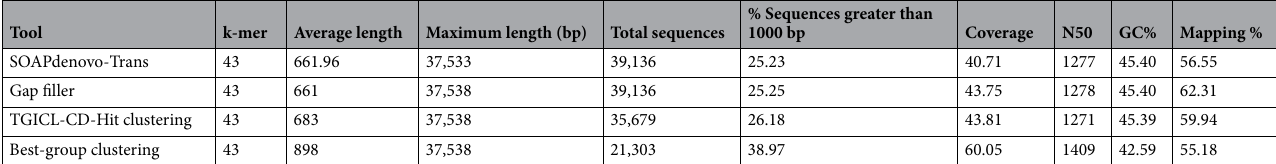
(Fig. 2). In terms of biological processes, dominance of “metabolic process” and “cellular process” was identified. Among the molecular function category, “binding”, “catalytic”, and “transporter” activity were identified as the most significant group. In terms of cellular components, “cell”, “cell part”, and “organelle” were the most domi- nant components. Thus, GO classification indicated that the plants were under metabolically active growth state involving various enzymatic and transportation activities. To identify the most abundant biological pathways and complex biological functional interactions in R. aus- trale , 9224 unigenes (43.29% of 21,303) were annotated using the Kyoto Encyclopedia of Genes and Genomes (KEGG) database (Fig. 1d, Supplementary Table S1). Among them, the highest number of unigenes belonged (TF) database representing 42.07% of the transcriptome classified into 62 TF families (Fig. 1d, Supplementary Table S1). Among all the TF families in R. australe , “bHLH” (16%) was the most abundant category followed by